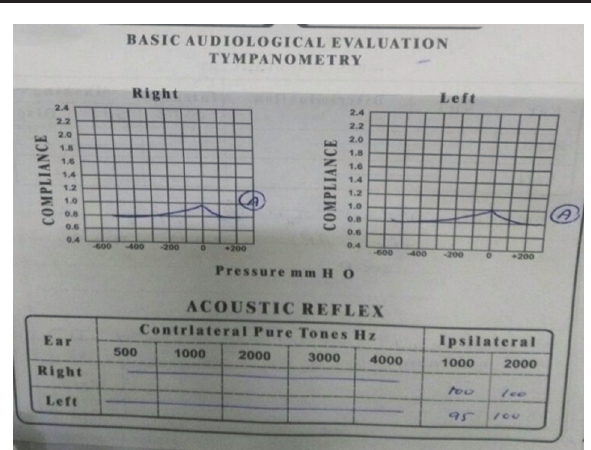
Tympanogram after 4 weeks of treatment showing improvement (bilateral type A tympanogram).